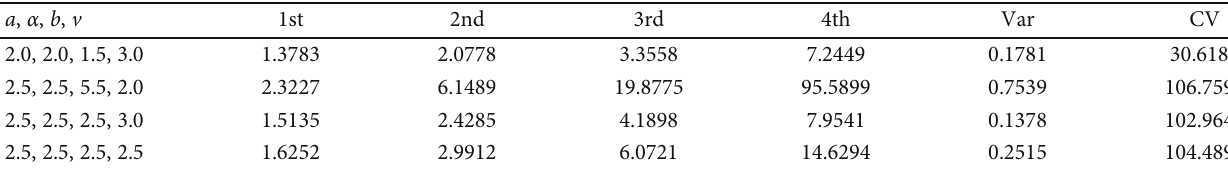
Table 2: Values for the fi rst four moments, Var , and CVof EGTT